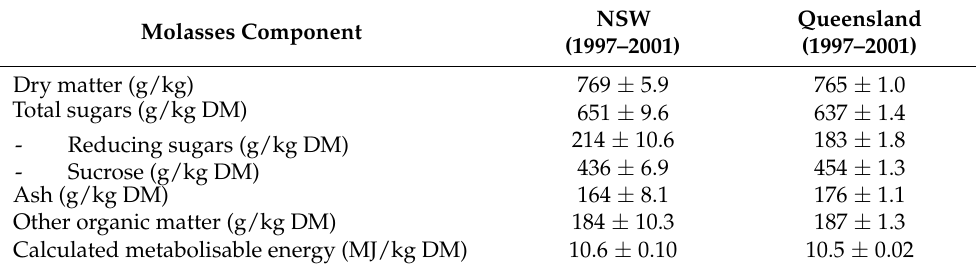
Table 3. Mean molasses composition from surveys of NSW and Queensland sugar mills